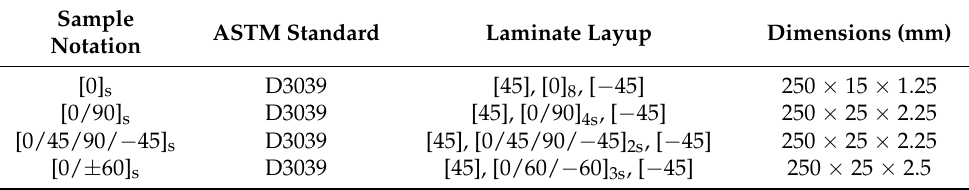
Table 1. Sample notation, international standard adopted for tensile testing, laminate layup (fiber reinforced layers placed in between roof and top PA layers), and sample dimensions (length × width ×